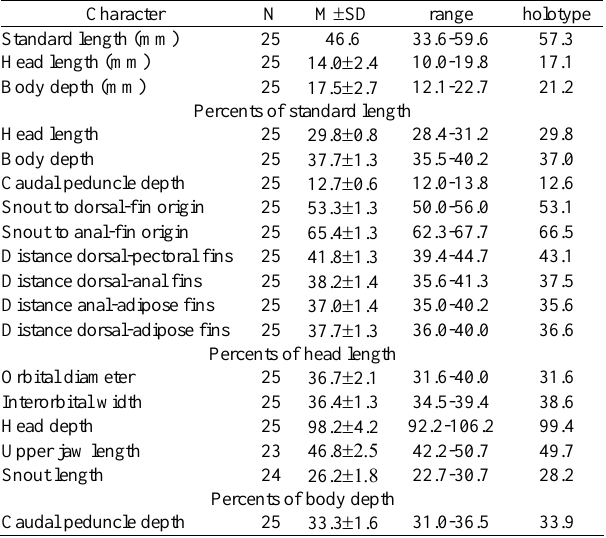
Table 1. Morphometric and meristic data of the holotype and paratypes of Astyanax xavante (N: number of specimens; M: mean; SD: standard